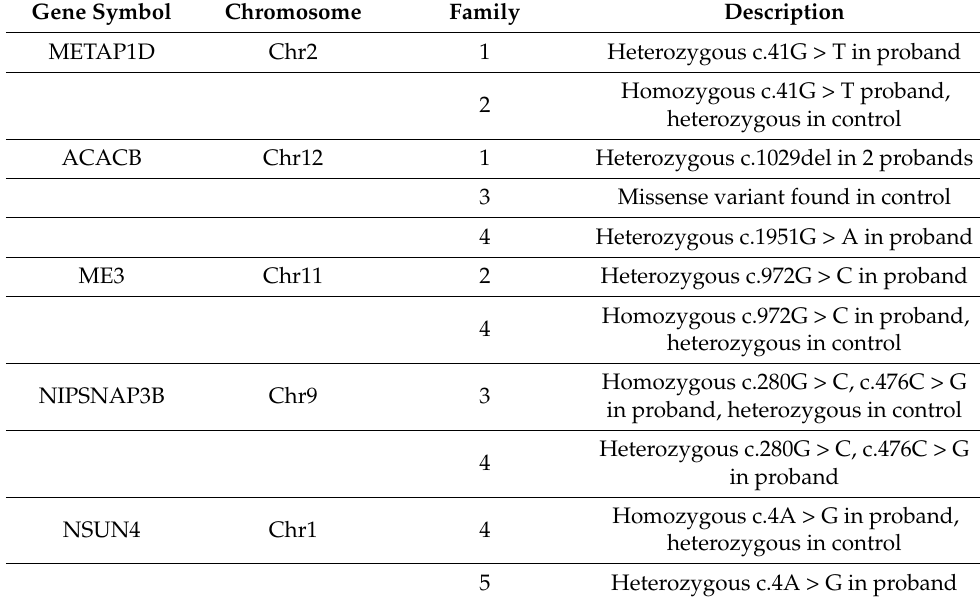
Table 4. Family-based analysis of mitochondria-related nuclear genes between the proband and control